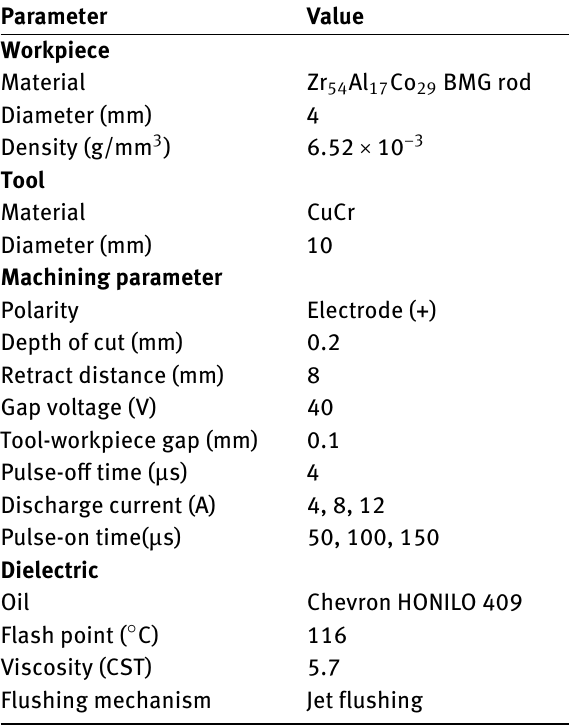
Table 1: Experimental conditions for biocompatible Zr-based BMG